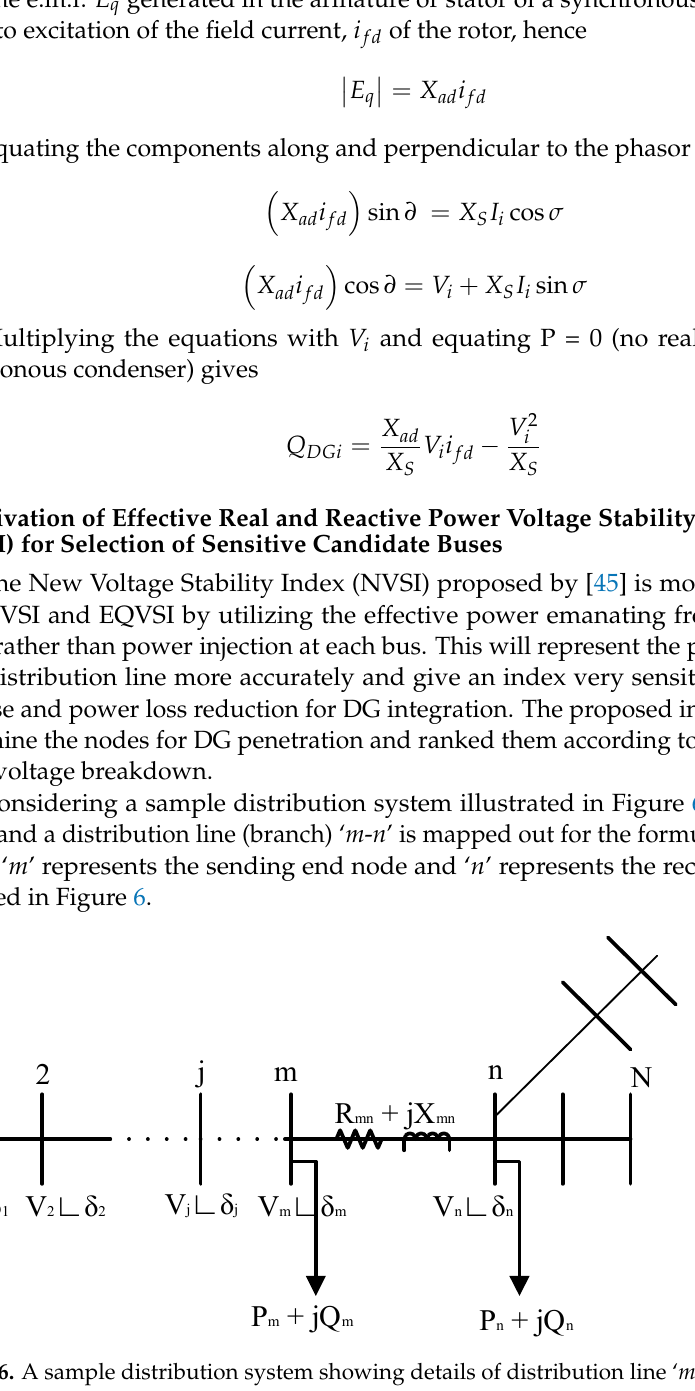
Figure 6. A sample distribution system showing details of distribution line ‘ m-n ’.